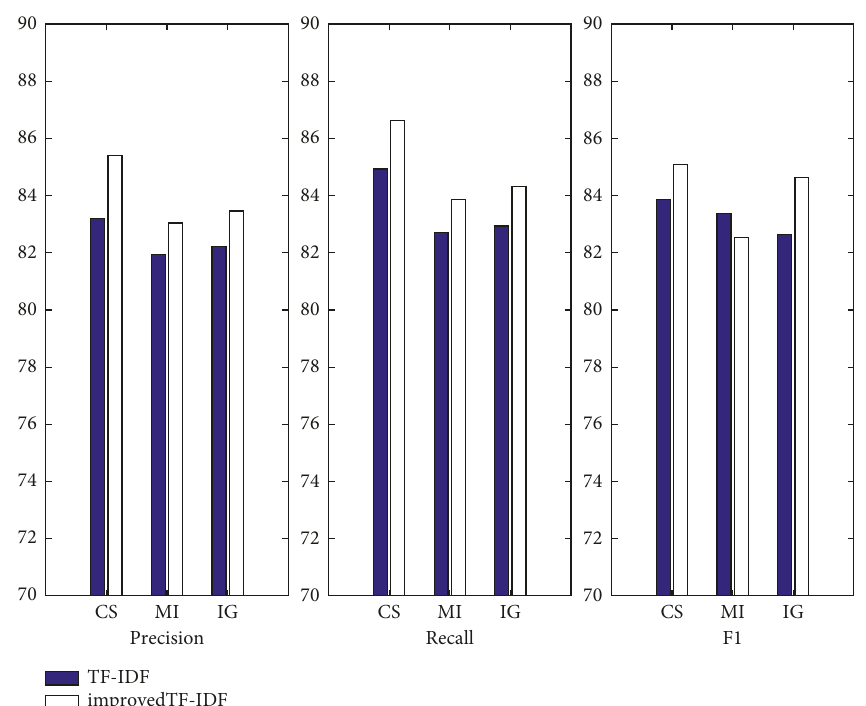
Figure 4: Comparison of indicators under different feature selection and feature weight